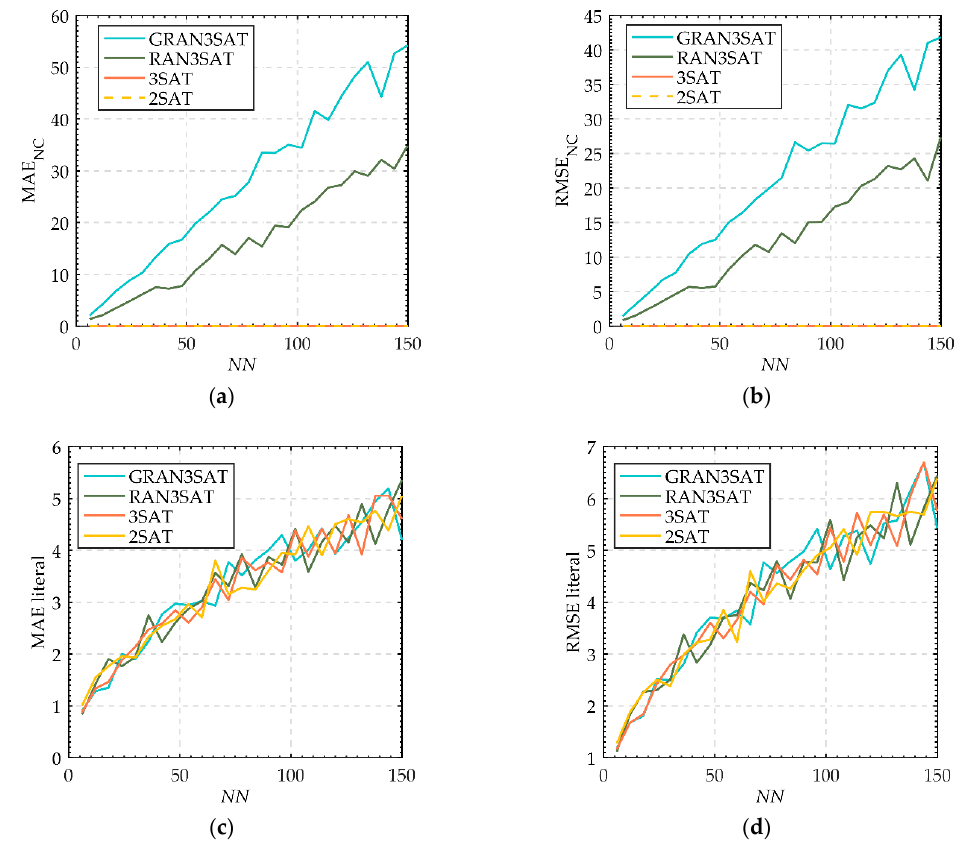
Figure 14. Flexibility error analysis of the proposed GRAN3SAT model compared with RAN3SAT [15], 3SAT [20], and 2SAT [9]: ( a ) MAE NC , ( b ) RMSE NC , ( c ) MAE literal , and ( d ) RMSE literal